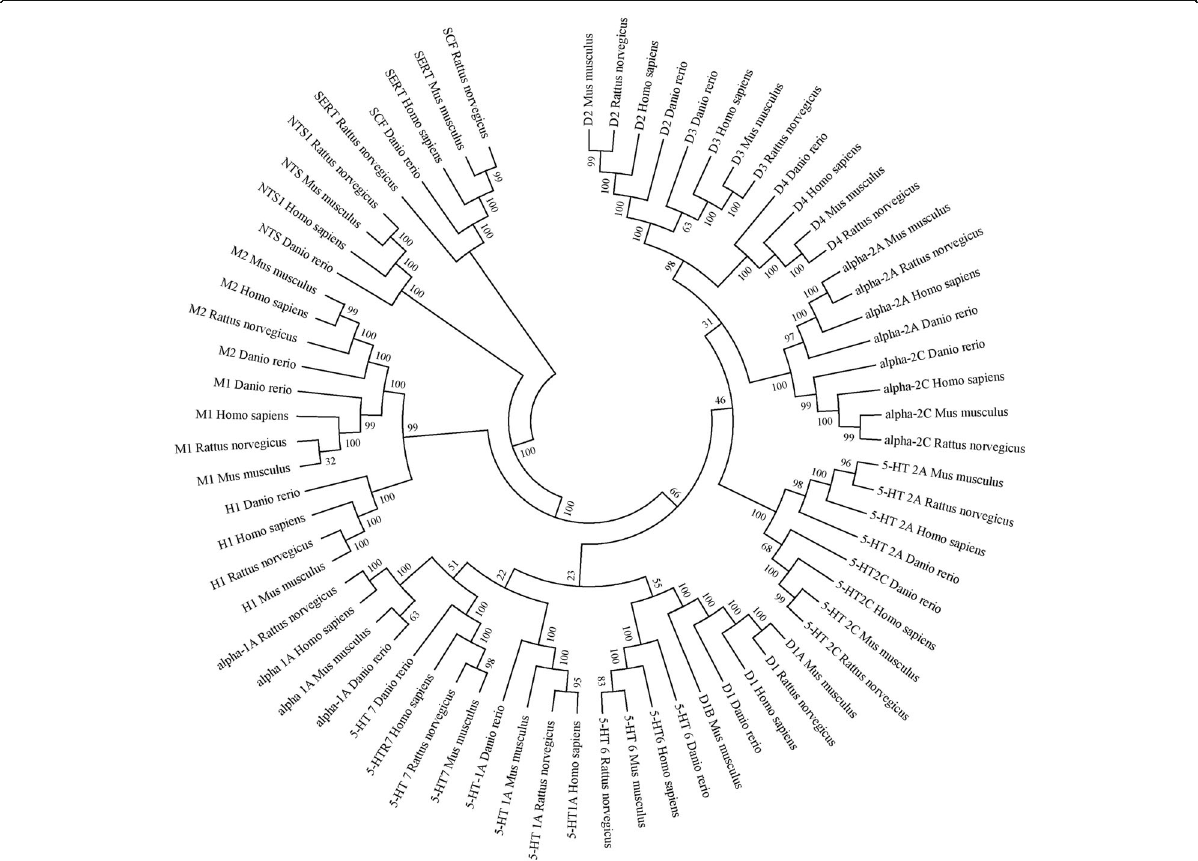
Fig. 2 Phylogeny comparison of receptors present in feeding and satiety center. The number at branching point refers to bootstrap score based on 500